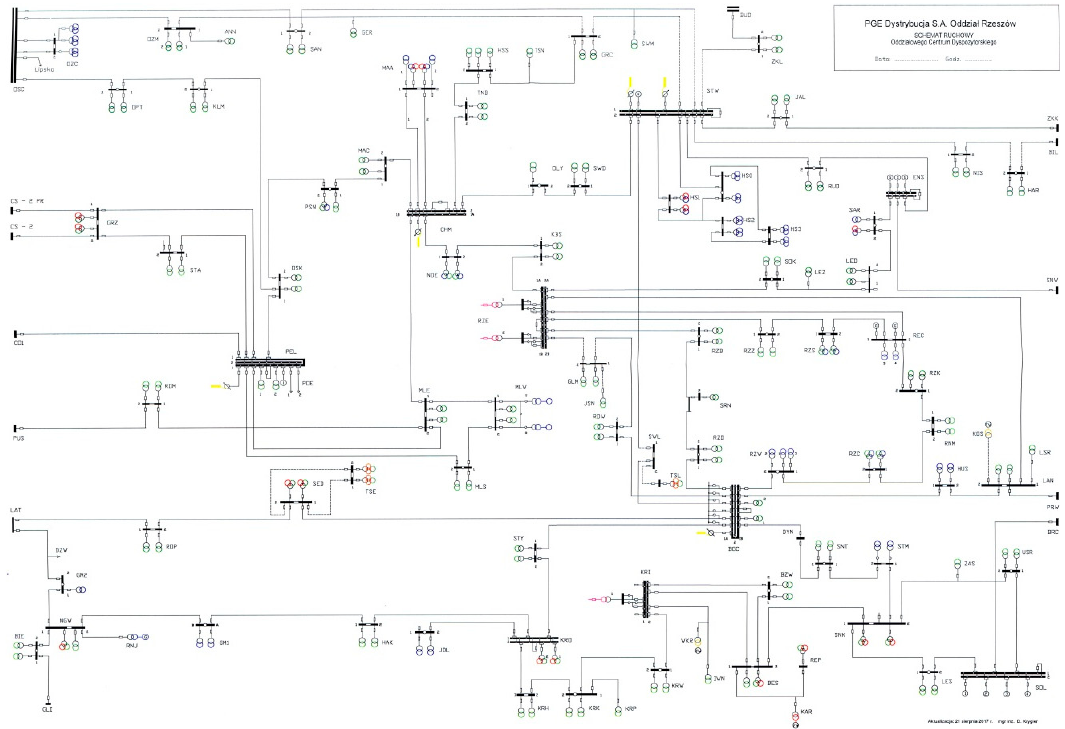
Figure 1. Sample part of the source data-network diagram obtained from DSO (Distribution System Operator).